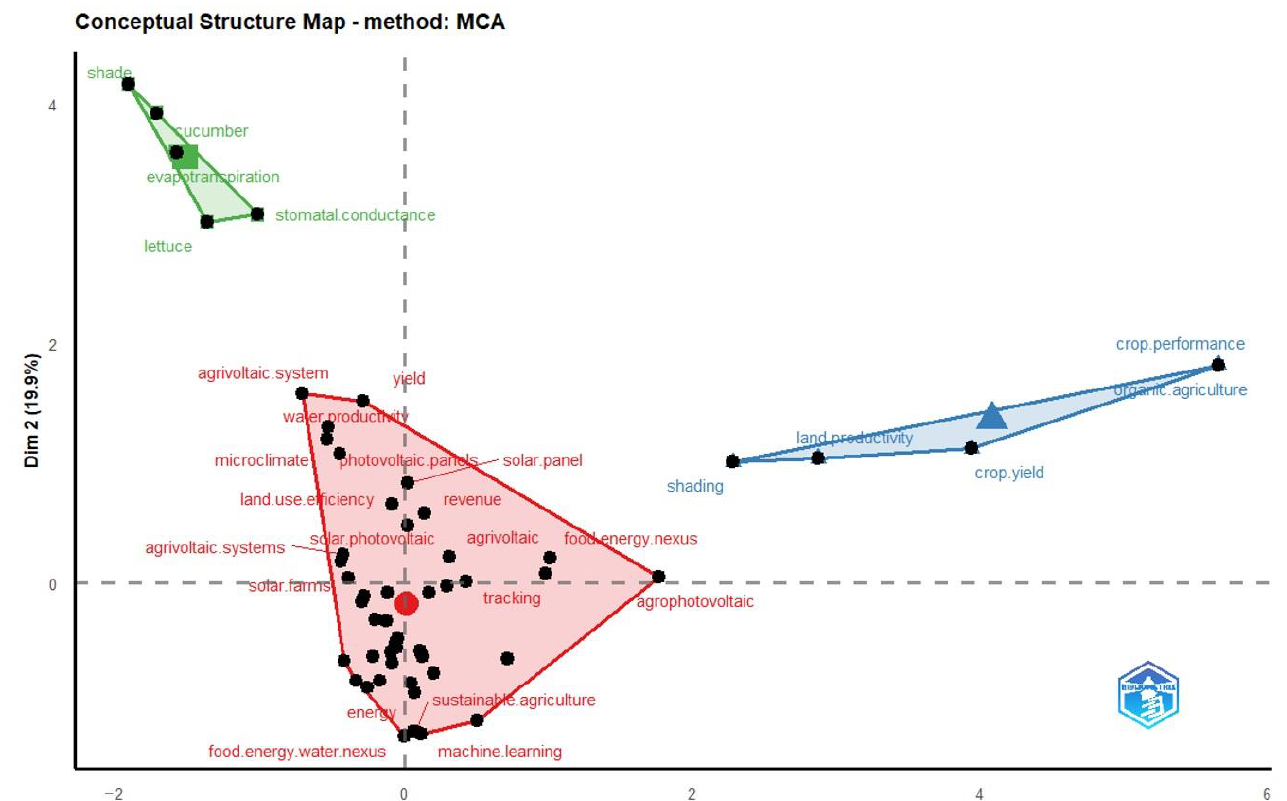
Figure 7. Multiple Correspondence Analysis of high-frequency keywords. Source: created by the authors.